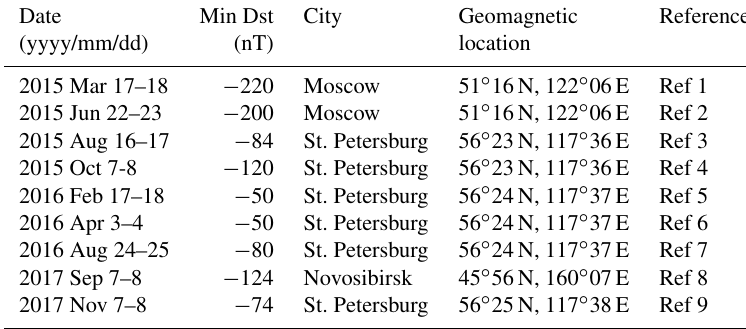
Table 1. Observations of discrete auroras in Russia from 2015 to 2017.